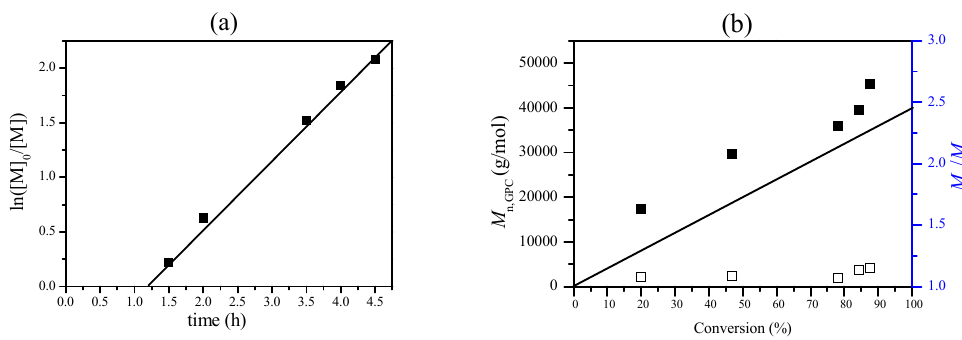
Figure 2. ln([M] 0 /[M]) as a function of polymerization time ( a ); number-average molecular weight ( M n,GPC ) and molecular weight distribution ( M w / M n ) versus monomer conversion; ( b ) for AGET ATRP with thiol-functional cellulose paper as reducing agent in the present of limited amount of air (oxygen). Polymerization conditions: [MMA] 0 /[EBPA] 0 /[CuBr 2 ] 0 /[PMDETA] 0 = 400/1/0.25/0.5, m [Cell-SH] = 50 mg, V MMA = 2.0 mL, V anisole = 1.0 mL, Temperature = 90 °C.